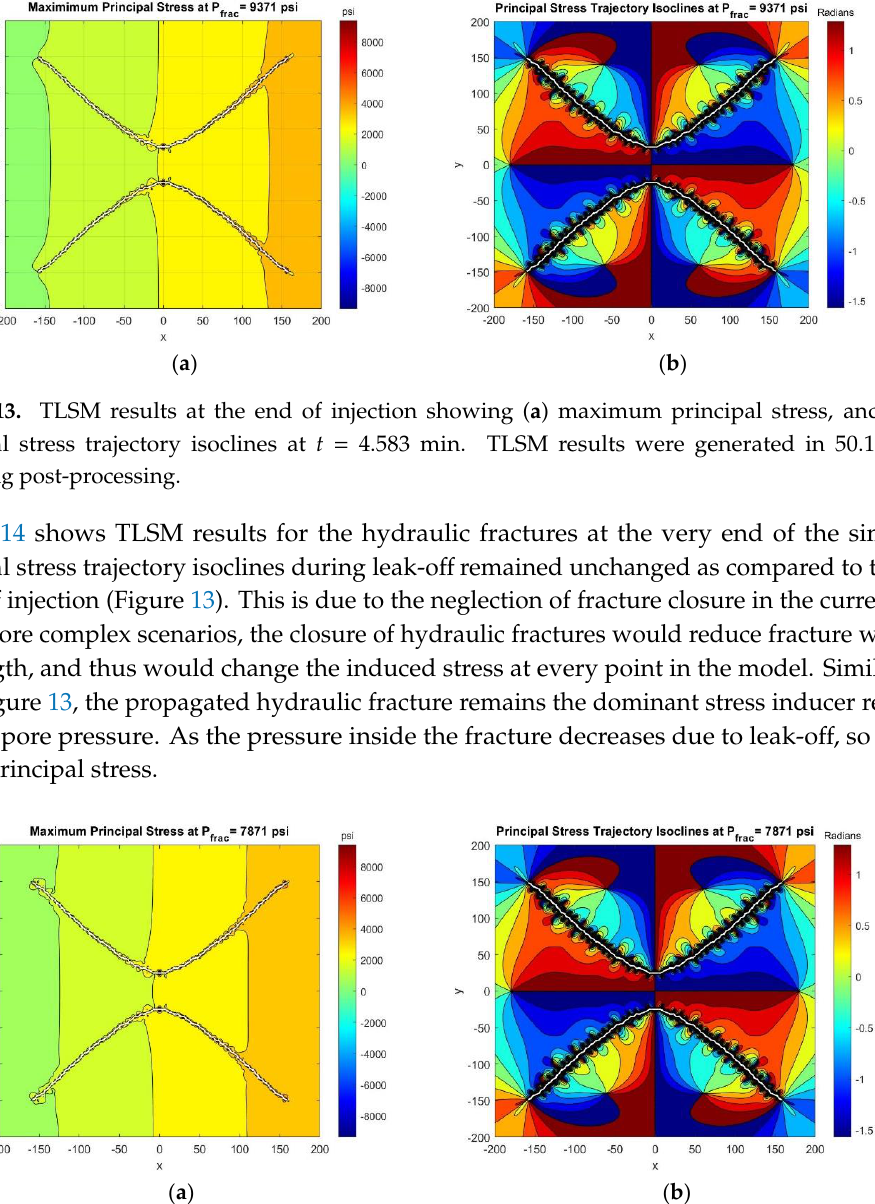
( b ) Figure 12. TLSM model results for the second successive hydraulic fractures showing ( a ) maximum principal stress, and ( b ) principal stress trajectory isoclines at t = 1.151 min. TLSM results were generated in 1.151 s including post-processing.